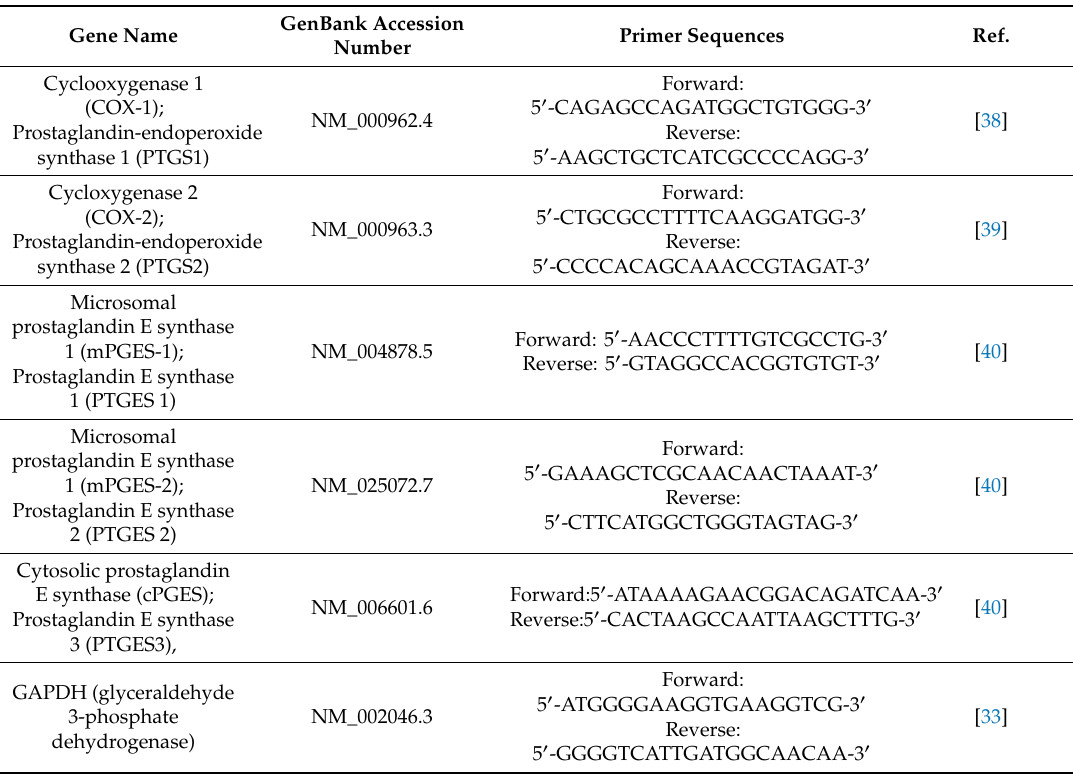
Table 2. Sequences of primers used for the quantitative reverse-transcriptase polymerase chain reaction (qRT-PCR) of gene